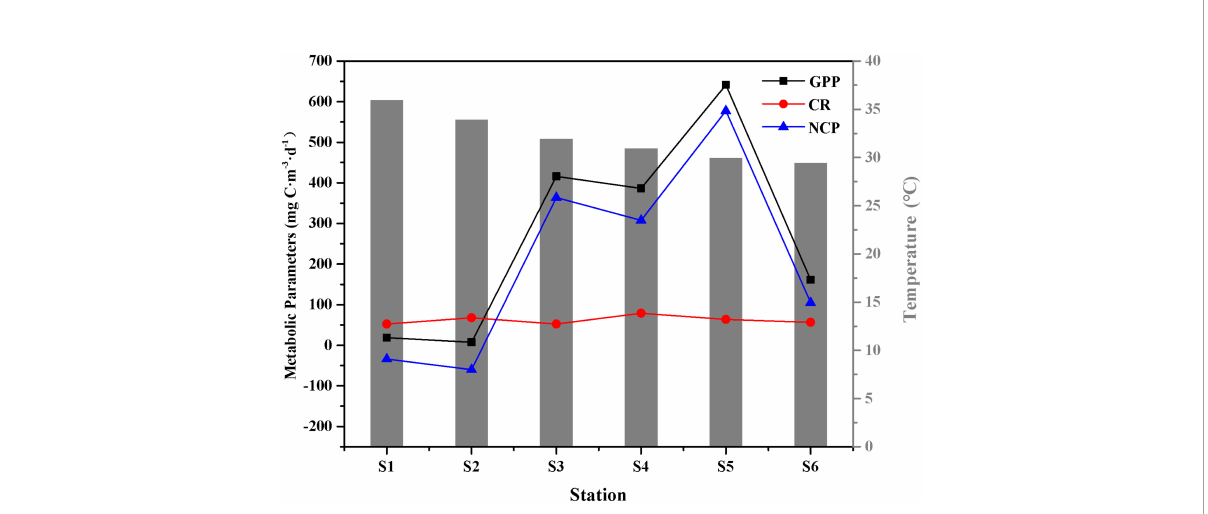
FIGURE 2 Features of plankton community metabolism during summer.Changes in CR are shown in red line and symbols, in NCP in blue line and symbols, and in GPP in black line and symbols, over time. CR, community respiration; GPP, gross primary production; NCP, net community